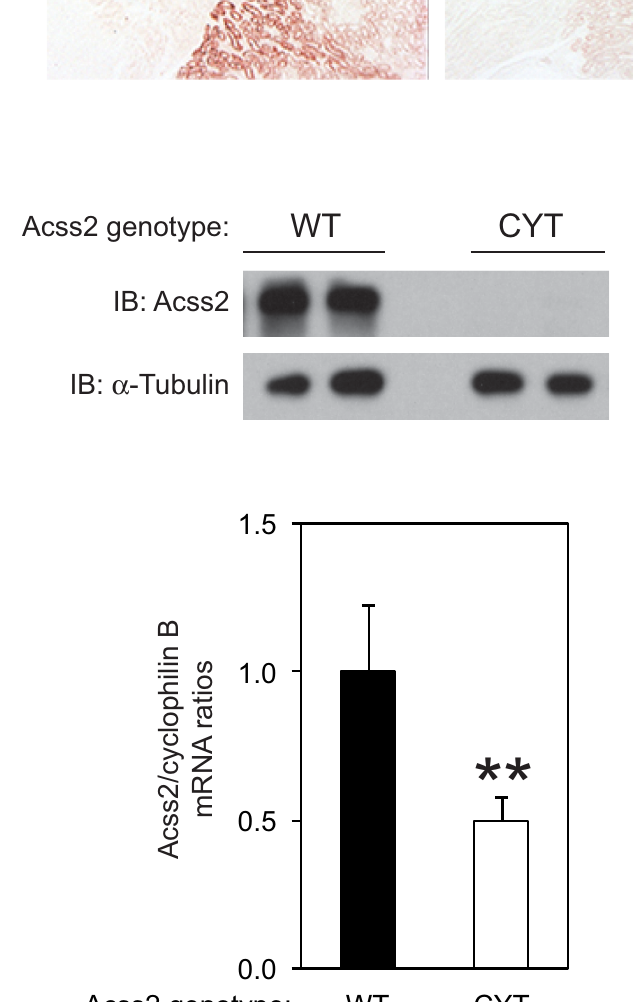
Fig 3. Acss2 protein levels are markedly reduced in ED Acss2 kidney. (A) Immunohistochemical and (B) immunoblot assays (two independent samples per group; normalized to protein amount and compared to